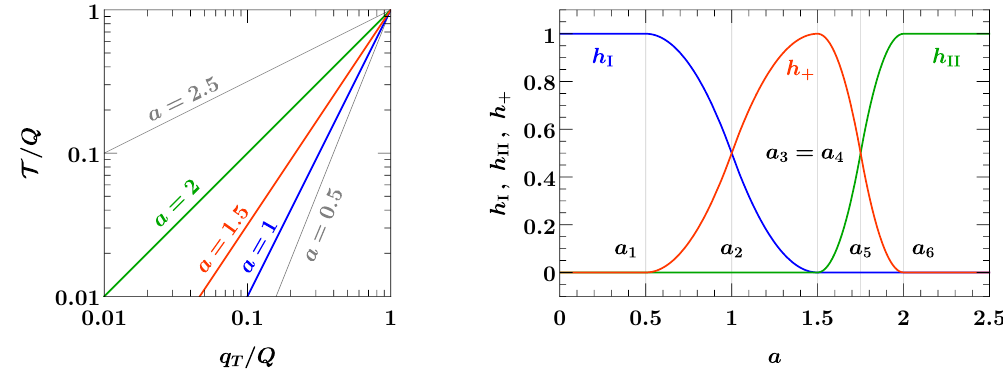
Figure 10 . Left: illustration of the regime parameter a that governs the matching between EFTs. We show lines of constant a in the ( q T ; T ) plane. For a = 1 the SCET I parametric relation is p exactly satis(cid:12)ed, q T = Q T , whereas for a = 2, the SCET II parametric relation is exactly satis(cid:12)ed, q T = T . Right: helper functions used to interpolate between scales on the boundaries (SCET I , SCET II ) and in the bulk (SCET + ). The helper functions have continuous derivatives and always sum to one. The individual helper functions are exactly one in their respective canonical regions. See the text for a detailed